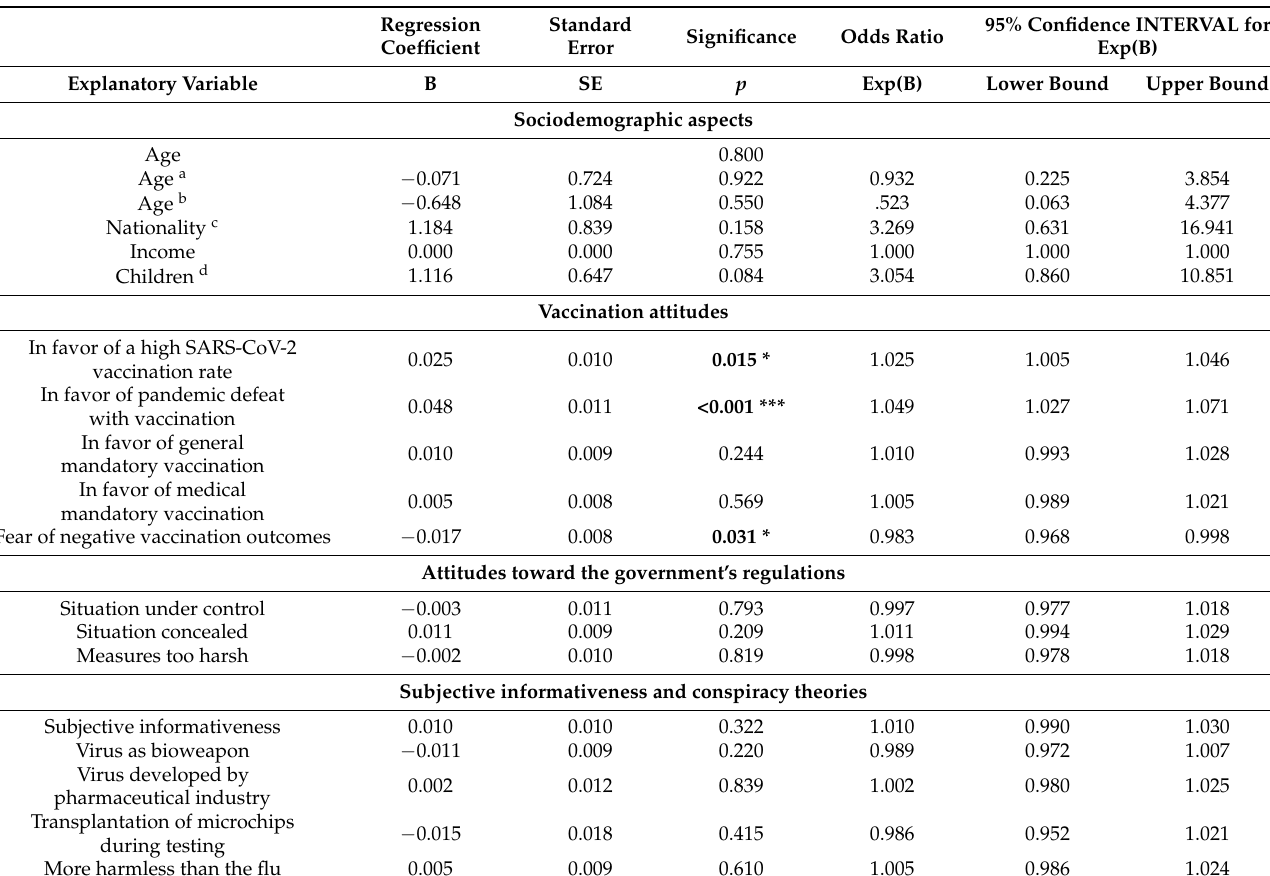
Table 5. Predictors for vaccination willingness, determined by a binary logistic regression analysis ( n = 224). Regression